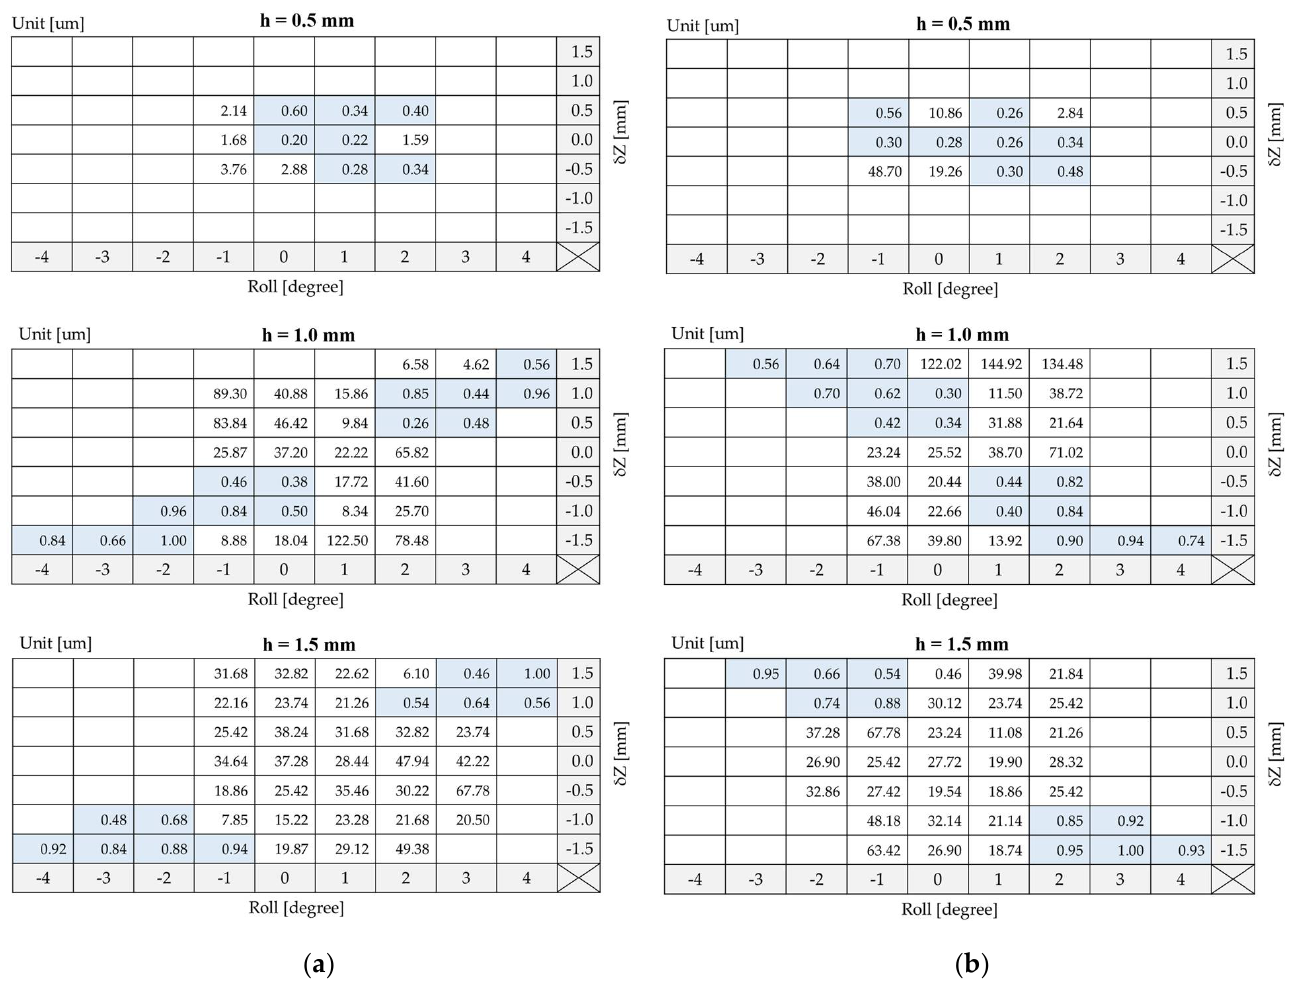
Figure 14. Experimental results of the standard deviations of ( a ) positive pulse and ( b ) negative pulse generated by the Wiegand sensor with different Roll angle and δZ offset values when h = 0.5, 1.0, 1.5 mm. The blue boxes highlight results of high position repeatability less than 1 um.